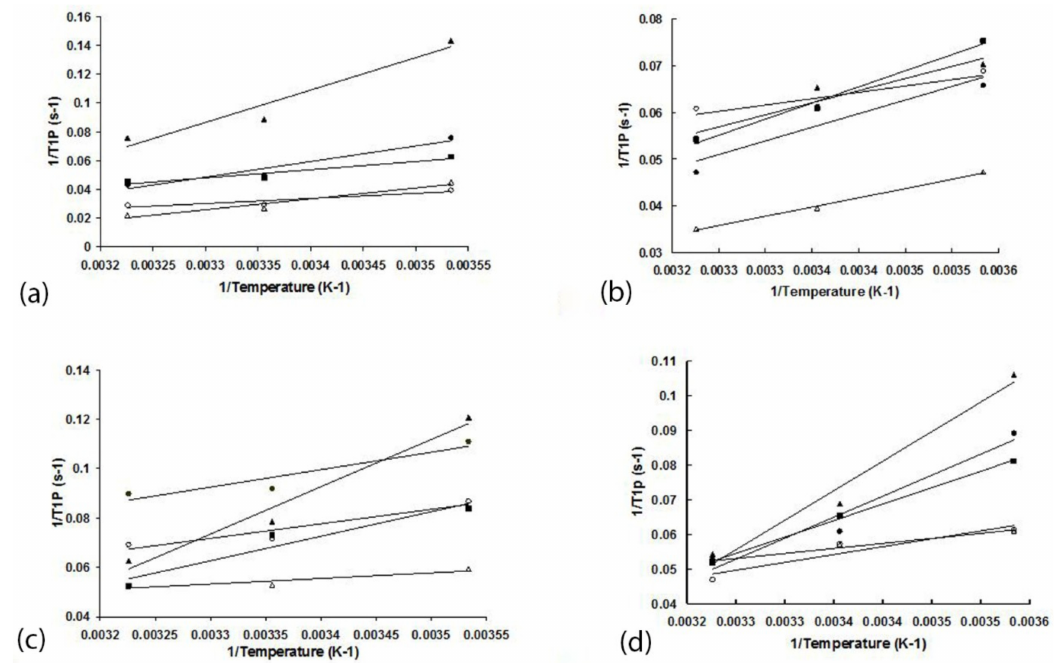
Figure 3. Temperature dependence of T 1P of phenacetin protons in the presence of CYP1A2 WT ( a ), N312L ( b ), L382V ( c ), and L382V/N312L ( d ) mutants. Positive slopes indicate that the substrate bound in the active site is in fast exchange with the surroundings. , phenacetin protons H2/6; (cid:78) , CH2; (cid:52) , COCH3; (cid:4) ,